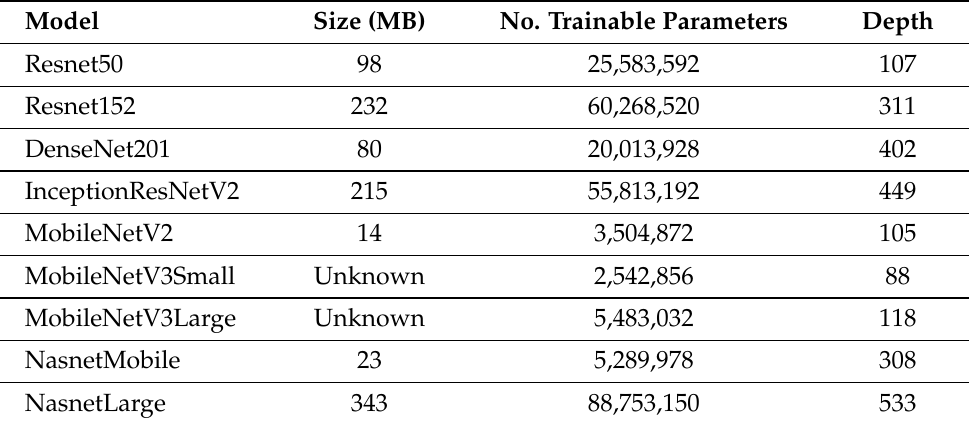
Table 4. Size, parameters, and depth of the backbone model used in this